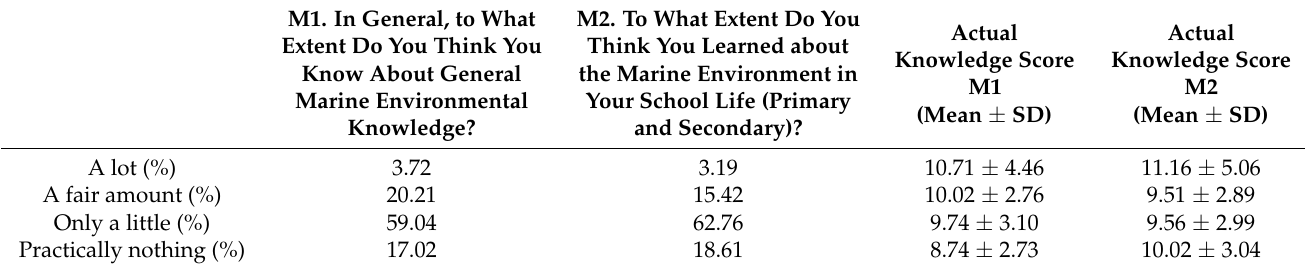
Table 3. Respondents’ self-evaluation of marine environmental